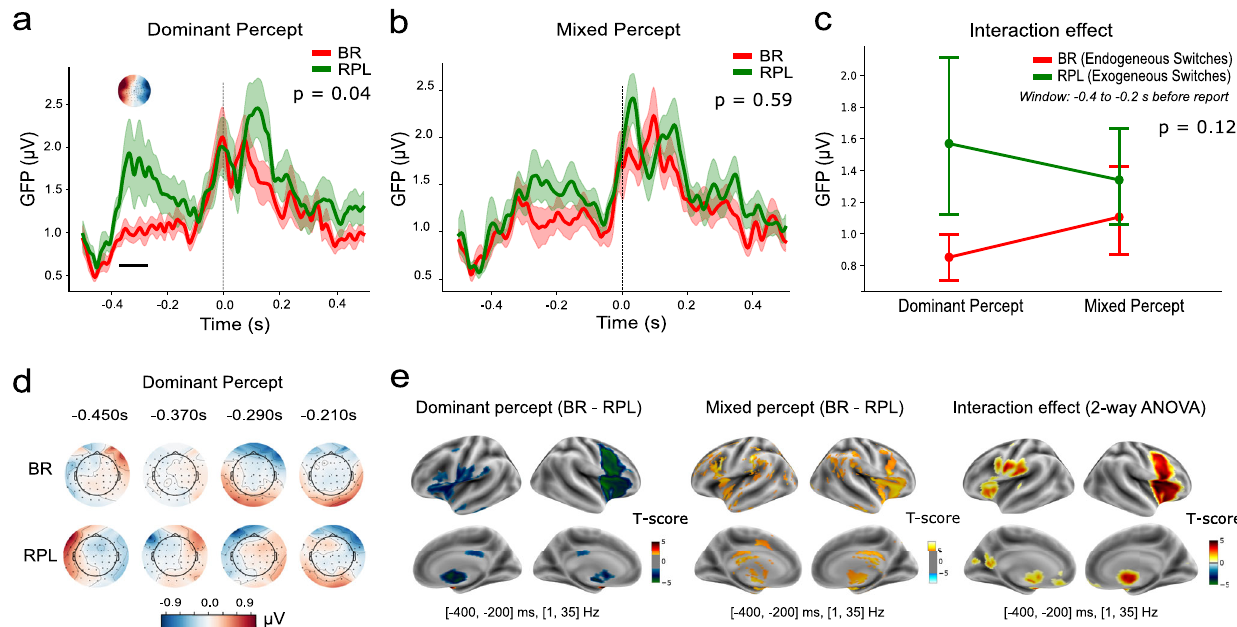
Fig. 3 | Event-Related Potentials for different perceptual conditions. a Event- RelatedPotentialcontrastbetweenBRandRPLfordominantperceptatthesensor level. The global fi eld power (GFP) in the RPL condition was signi fi cantly higher than that in BR condition from − 400 to − 200ms before the reported change in percept at 0s. This is indicated in the plot with the black horizontal line ( p -corr <0.05 signi fi cant clusters, by one-sample permutation cluster t -test). The ERP topographyforthe “ BR(dominant)vs.RPL(dominant) ” contrastisdisplayedatthe topofthesigni fi canttimewindow. b Nosigni fi cantdifferencewasfoundintheGFP between the BR (mixed) and RPL (mixed) conditions. c GFP difference across sources of perceptual transitions and types of percept. The interaction effect was